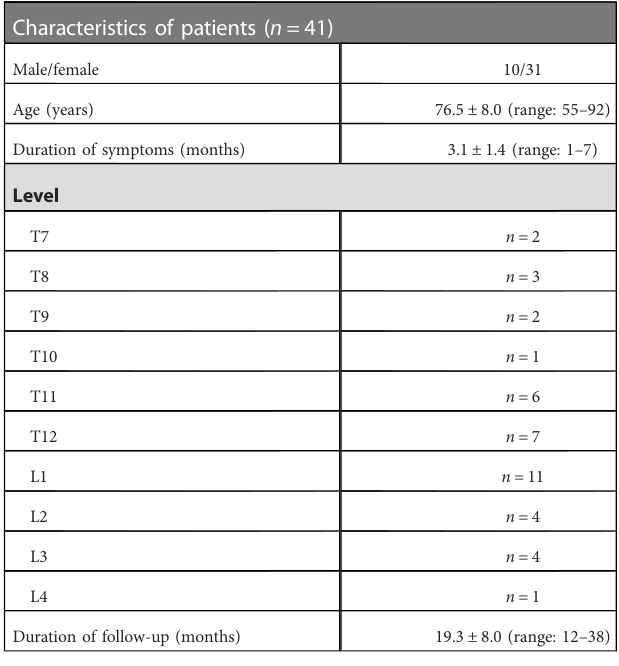
TABLE 1 Baseline characteristics of the